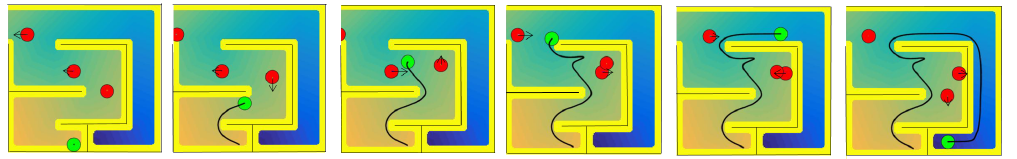
Figure 12. Global navigation plan. Robot employs a heuristic graph search strategy. The color gradient shows the Dijkstra heuristic field for the maze. The interaction horizon is τ = 4 s. The safe control inputs are computed, which are neither in control obstacle nor did they lead to a collision with the static obstacle. At the same time, Dijkstra heuristic function computes the cost for reaching the goal. A safe control input is executed which minimizes the cost and has margin greater than or equal to β =